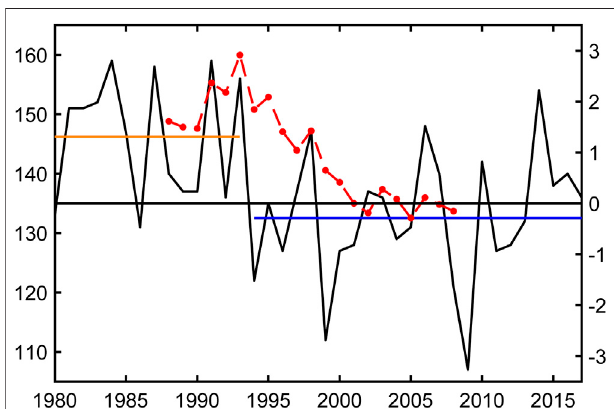
FIGURE 1 | Time series of the SCSSM onset date during 1980 – 2017. The left Y-axis is the sequence number of day for the SCSSM onset date from 1 January (day). Orange and blue lines denote the mean onset date in 1980 – 1993 and 1994 – 2017, respectively. Red dashed curve is the 9 years sliding t -test value (right